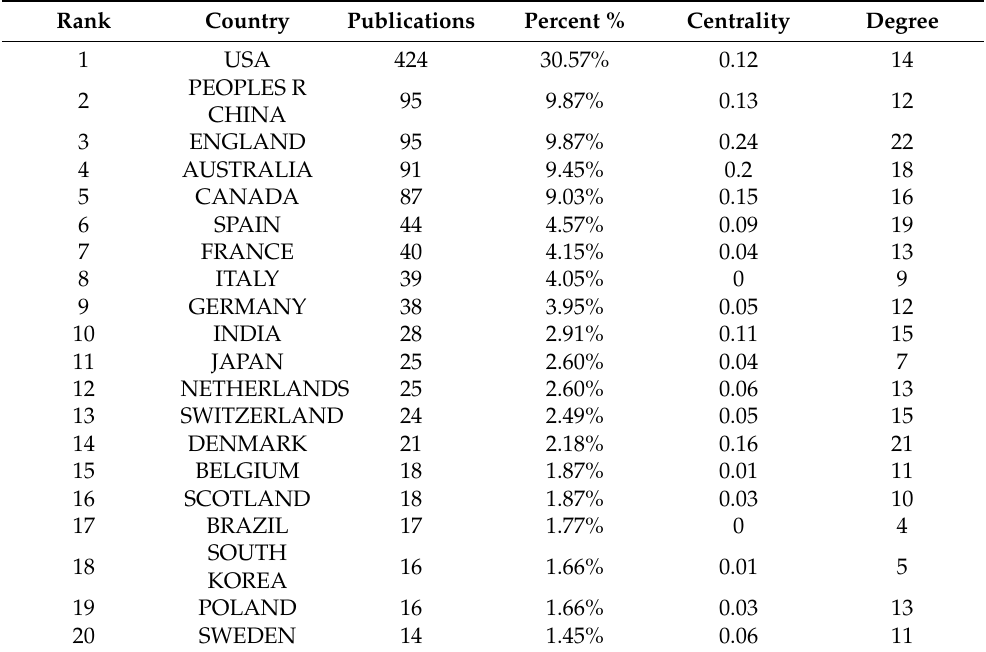
Table 3. The top 20